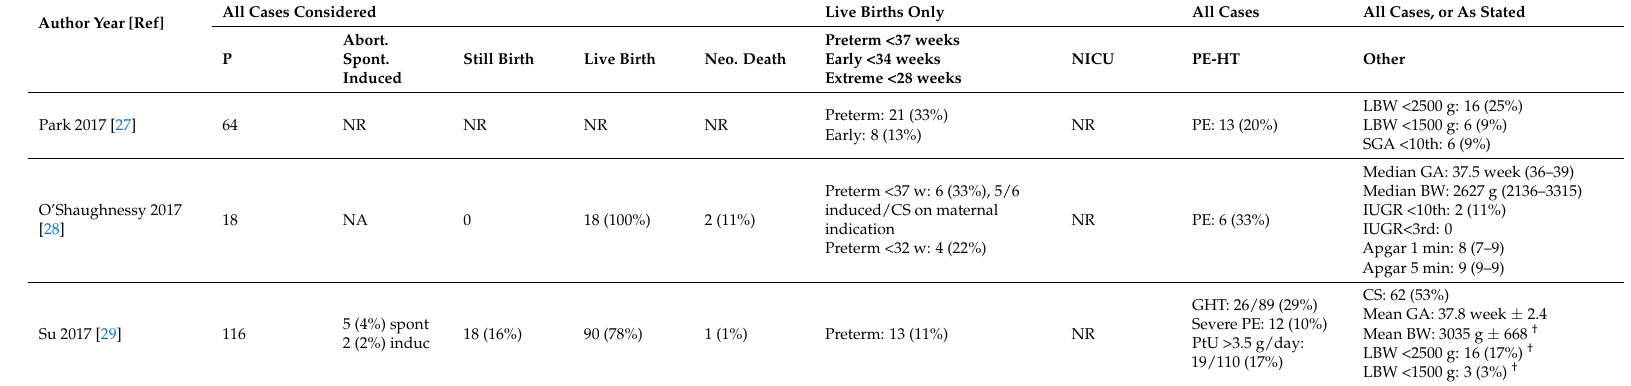
Table 3. IgA Nephropathy: Fetal and pregnancy outcomes in the case